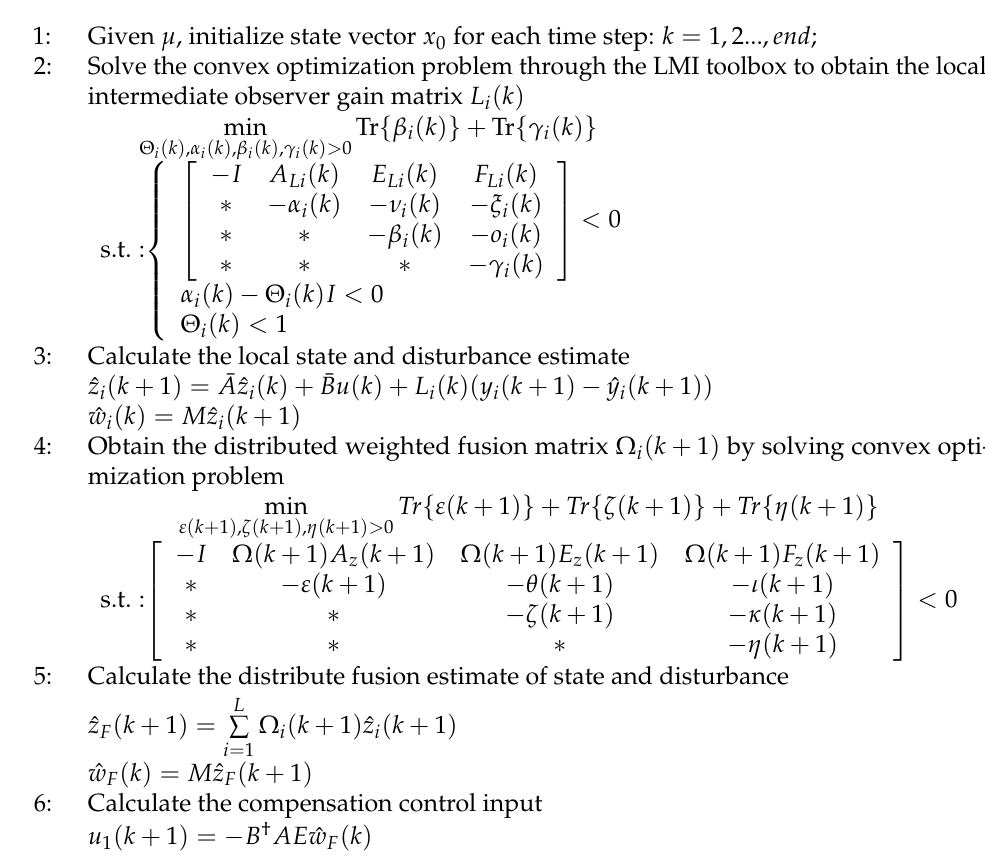
Algorithm 1. Intermediate-variable-based distributed fusion